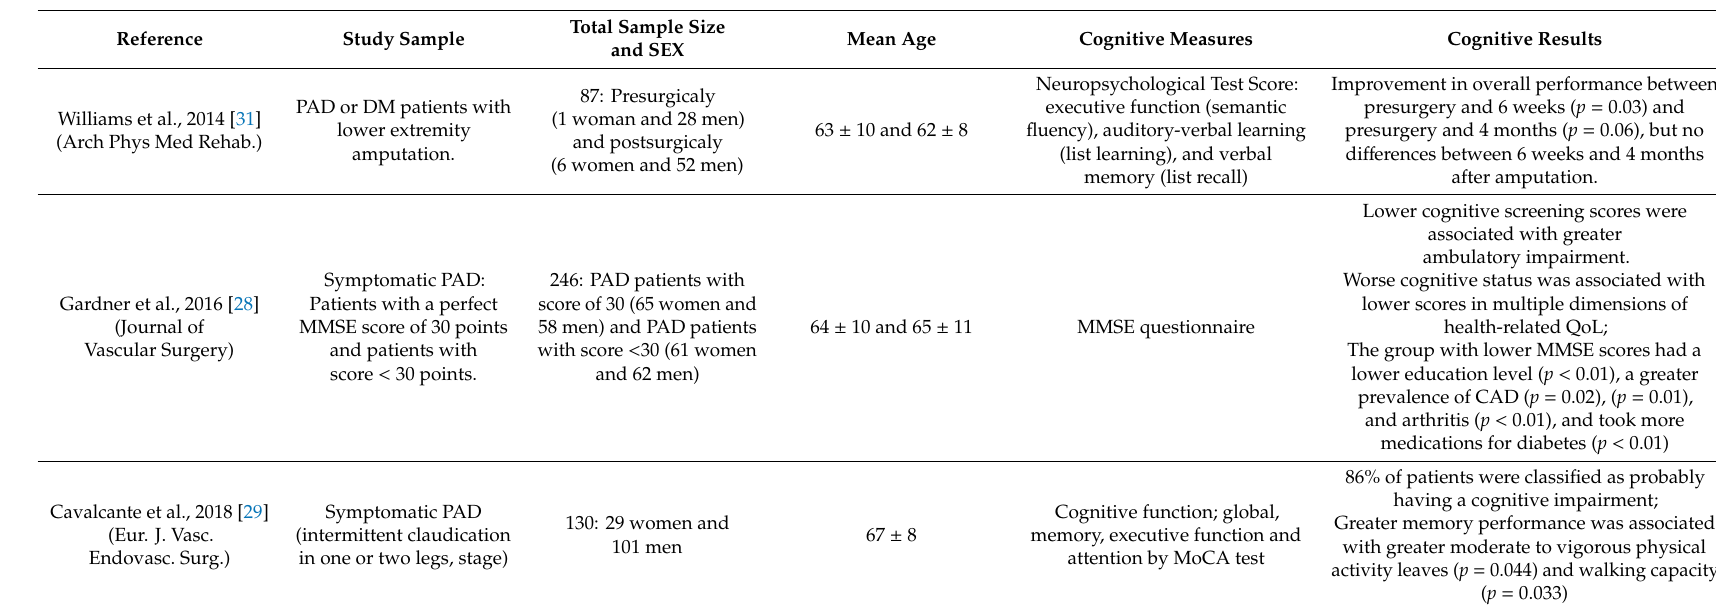
Complex Figure SPMSQ: short portable mental status questionnaire; WAIS-R: Wechsler Adult Intelligence Scale-Revised; WMS-R: Wechsler Memory